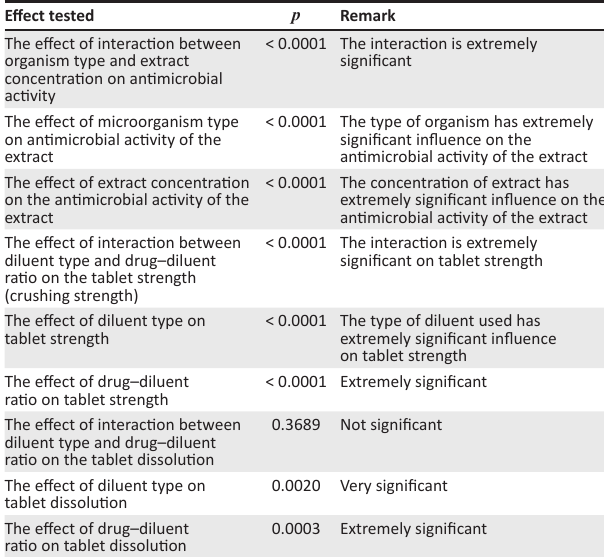
TABLE 6: Outcome of statistical analysis. TABLE 5: The dissolution times of Ficus exasperata herbal tablets having highest